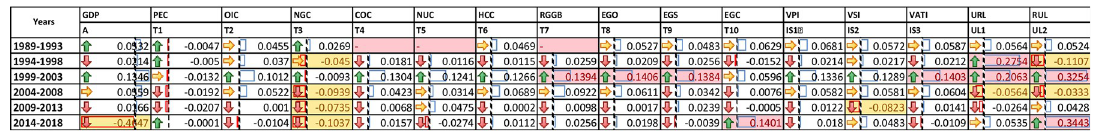
Fig 12. Five years alpha. Note: Variable’s definition stated in Table